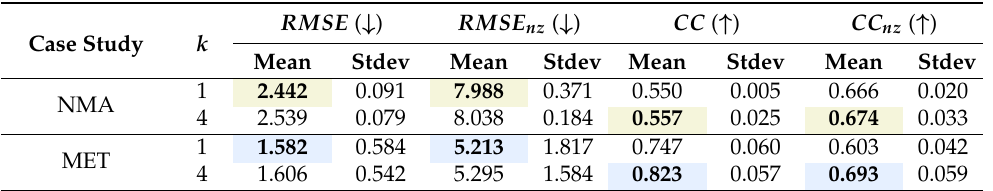
Table 2. The results for the regression evaluation metrics for predicting one time step in the future, where k denotes the number of previous time steps that were used in the predictions. The means and standard deviations that were computed across the three experimental runs are shown. The best values for the performance metrics are marked with bold and colored with yellow (for the NMA case study) and with blue (for the MET case study).